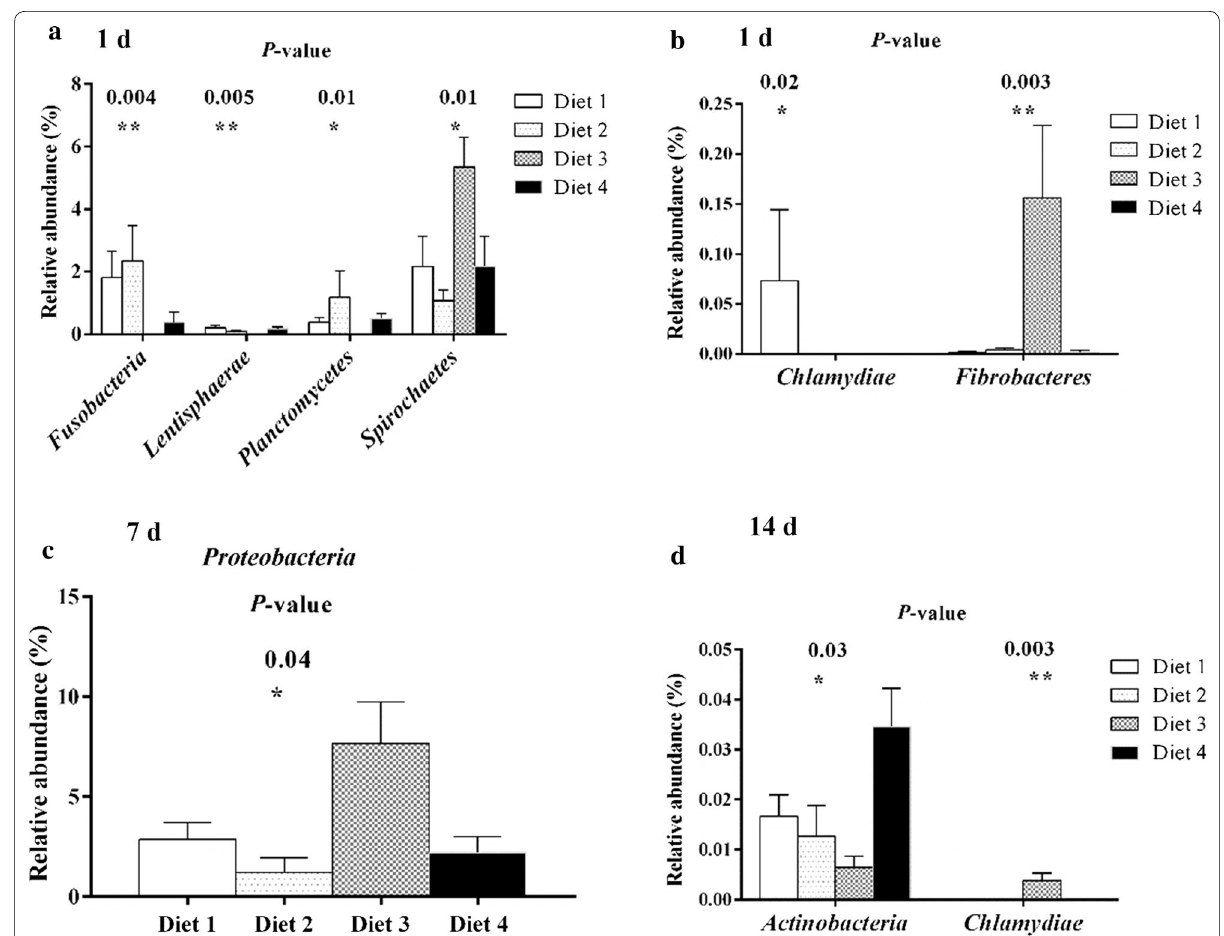
Fig. 5 The bacterial abundance of phyla significantly differs in different phases. Only the data whose differences with P -values lower than 0.05 are shown. Day 1 ( a , b ), day 7 ( c ), and day 14 ( d ) represent experimental day 1, 7, and 14, respectively. * P < 0.05, ** P <